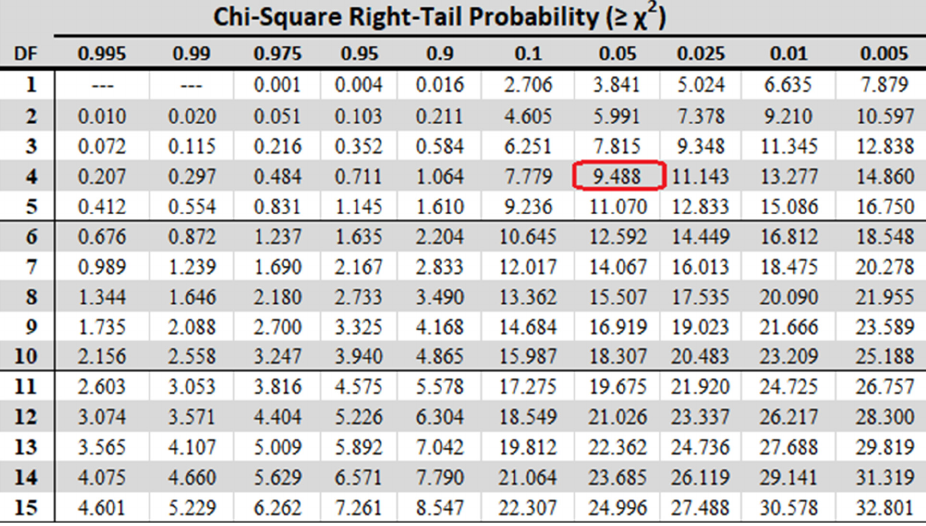
Figure 22. Chi-Square Table.